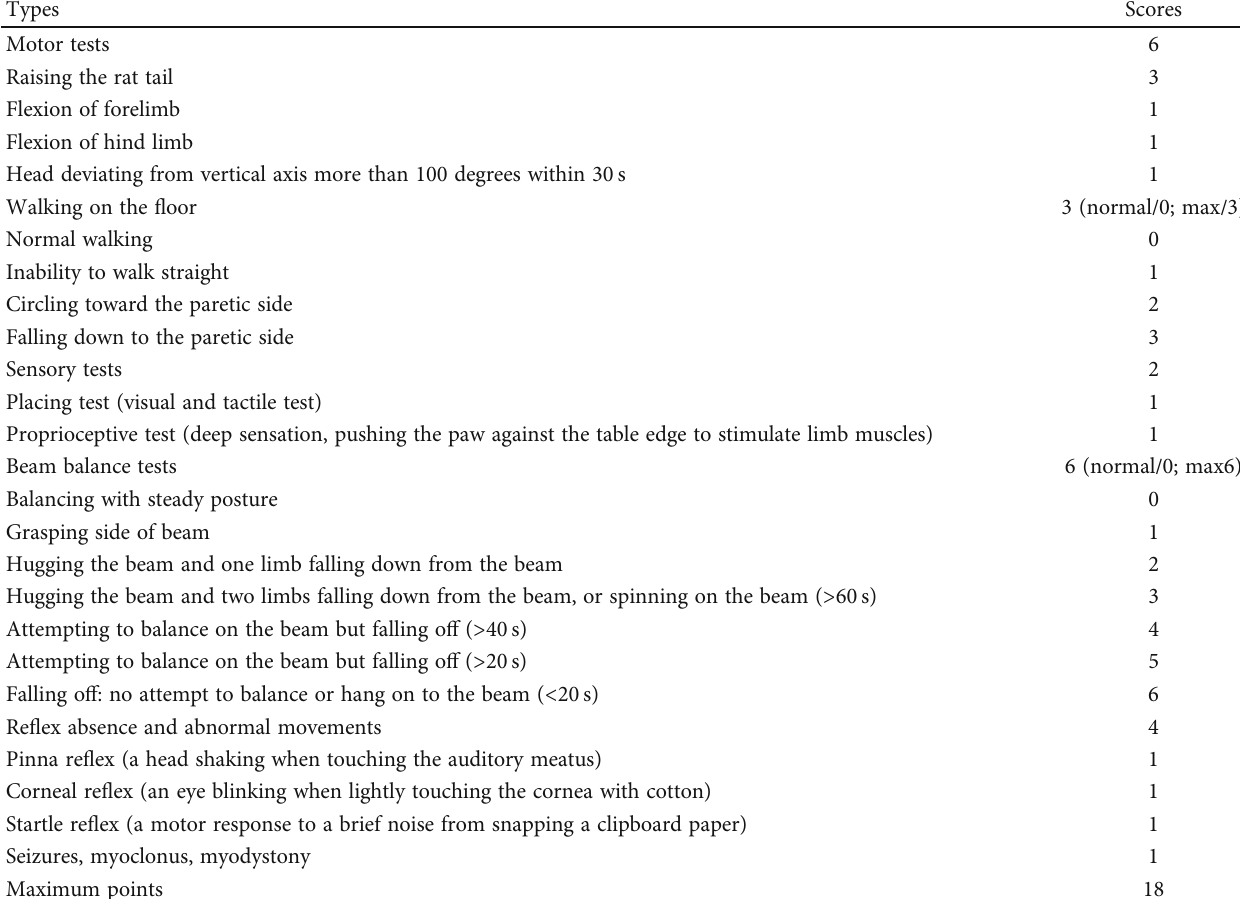
Table 1: Modi fi ed neurological severity